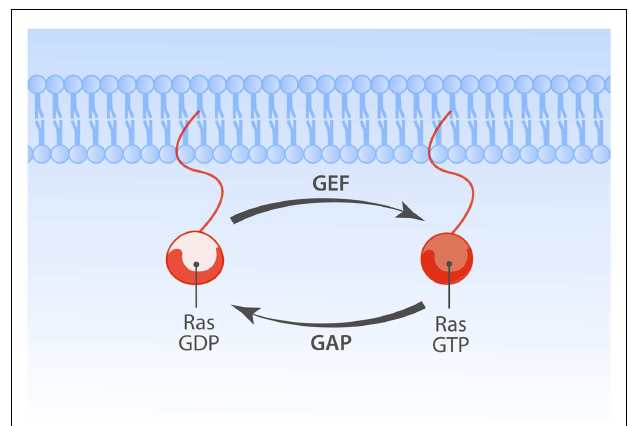
FIGURE 1 | Regulation of Ras family proteins .The Ras GTPases cycle between GDP-bound inactive and GTP-bound active forms. Activation of Ras is regulated by the balance of opposing actions of two classes of Ras regulatory enzymes. Guanine nucleotide exchange factors (GEFs) promote GTP-bound Ras state by enhancing exchange of GDP with GTP. GTPase activating proteins (GAPs) enhance slow rate of intrinsic Ras GTPase activity, promoting the inactive GDP-bound state of Ras.